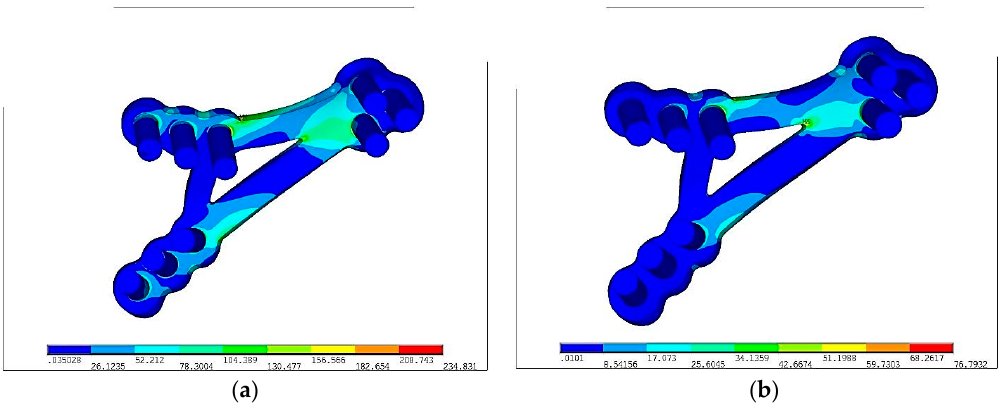
Figure 8. Equivalent stress distribution on plates according to von Mises hypothesis following plate fixation in the maximal loading according to the literature [16]: ( a ) Ti-6Al-4V plate fixation, σ red max = 234 MPa, ( b ) PLLA plate fixation, σ red max = 76 MPa; Colors from blue to red means stresses from 0 to maximum.